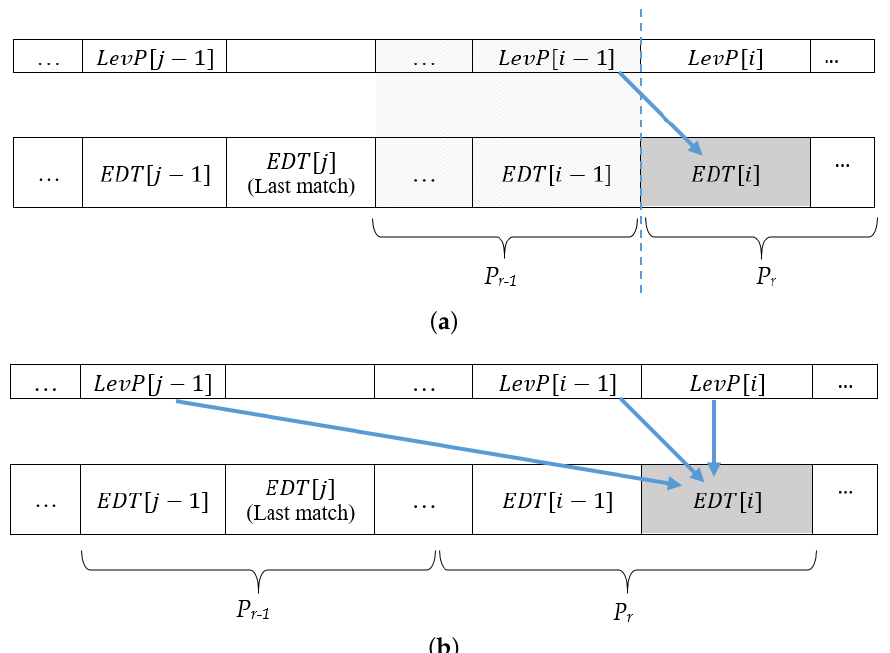
Figure 8. Two cases where the computation of a cell requires values from preceding processors. The computation of EDT [ i ] is dependent upon the values LevP [ i ] , LevP [ i − 1 ] and LevP [ j − 1 ] . ( a )